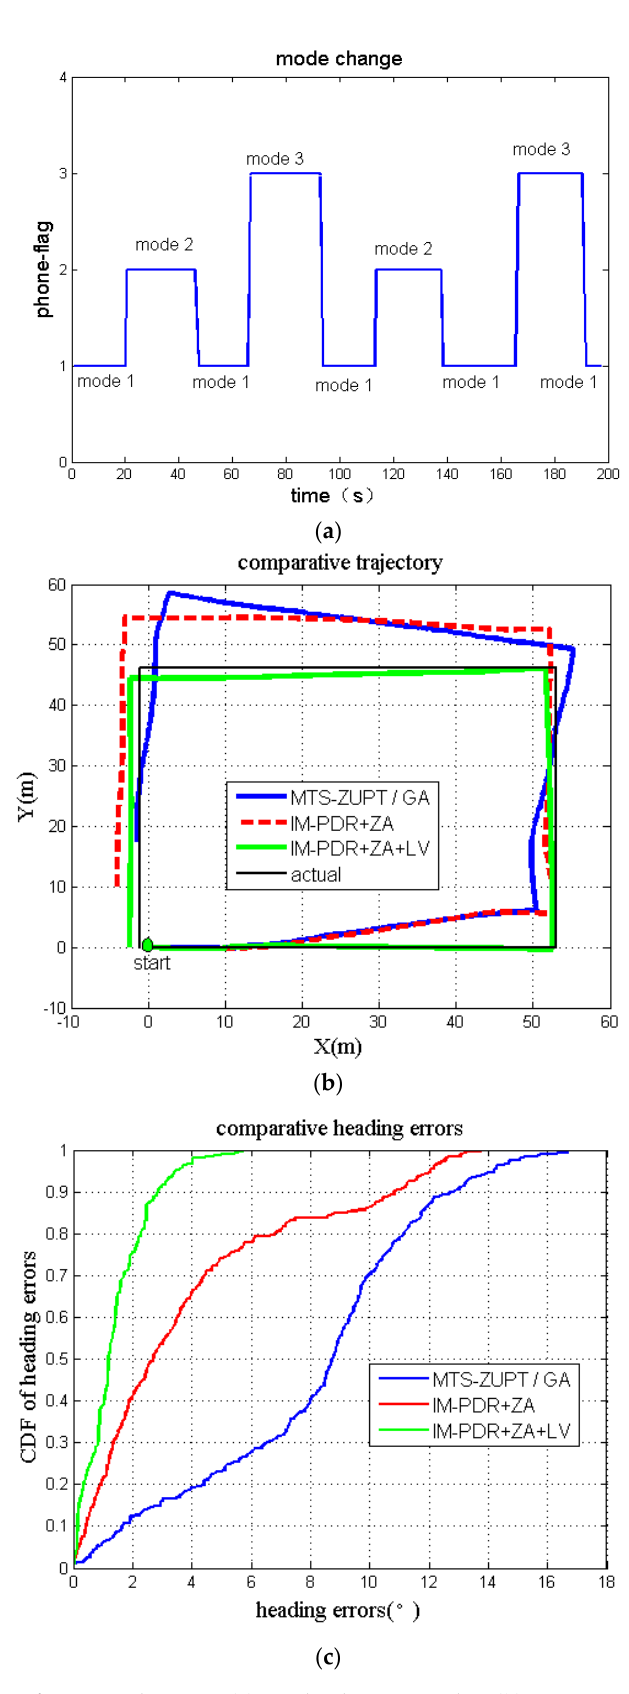
Figure 12. Results of rectangular test: ( a ) mode change results; ( b ) comparative trajectories; ( c ) comparative heading